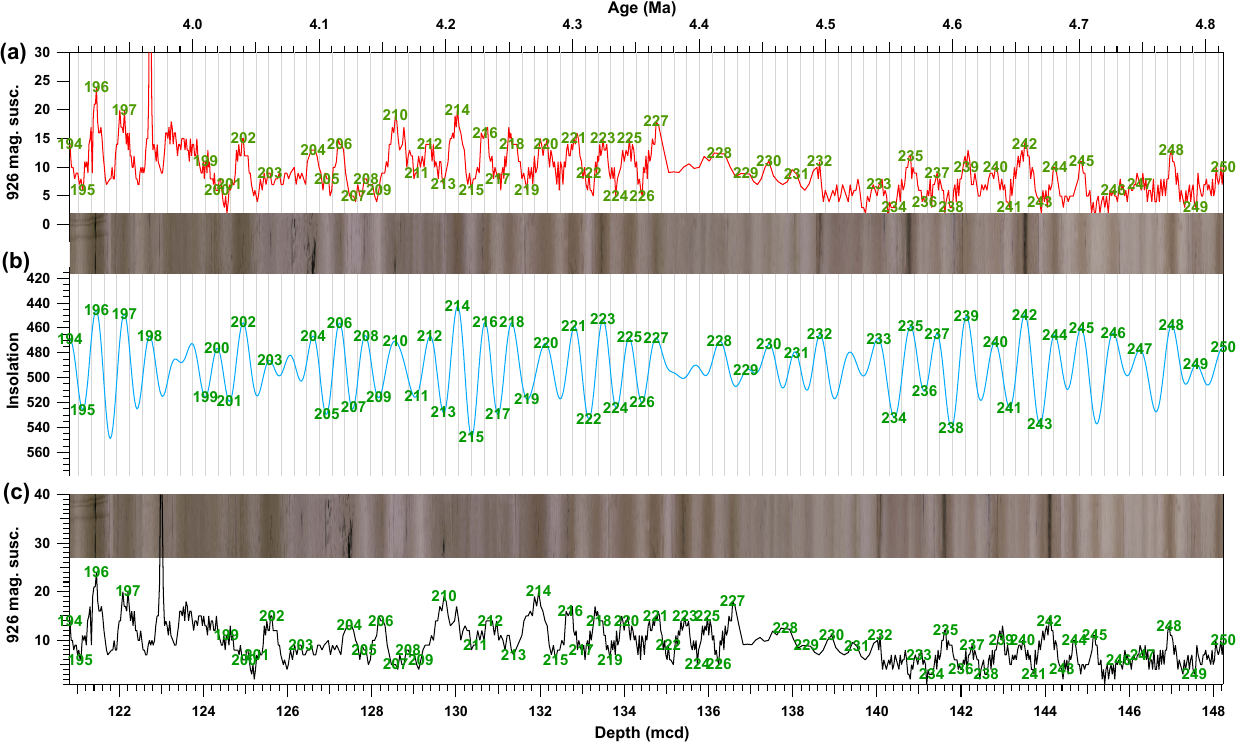
Figure 10. Detail from CODD tuning of Site 926 magnetic susceptibility and core images to insolation. Panel (c) is data versus depth, (b) shows insolation 65 ◦ N 21 June inverted, and (a) shows image and magnetic susceptibility versus tuned age. Green numbers mark position of tie points. Numbers identify tie points between the data and the insolation curve. Light/dark layering in the composite core image is tied to precession cycles prominent in the insolation curve.